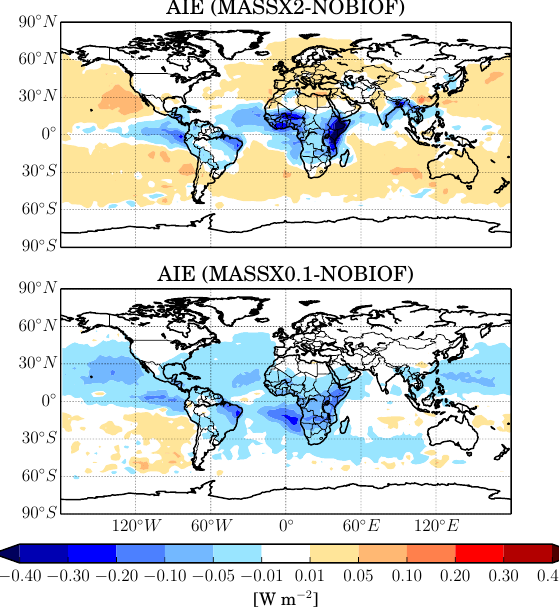
Figure 8. The AIE for the MASSX2–NOBIOF comparison (top, mean: + 0.002Wm − 2 ) and MASSX0.1–NOBIOF comparison (bottom, mean: − 0.014Wm − 2